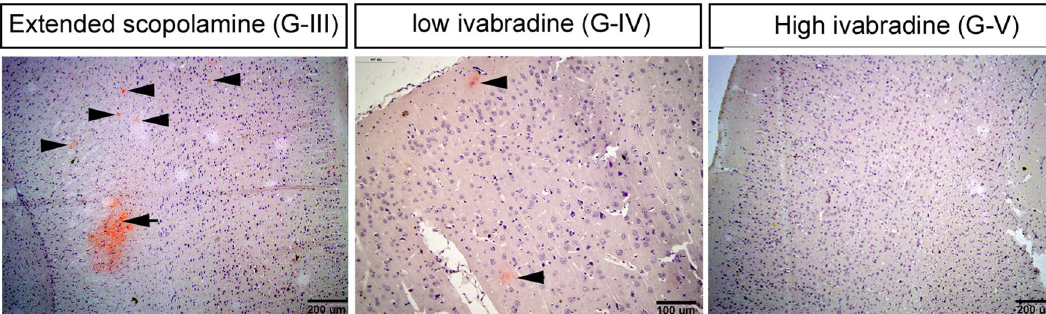
Figure 7. Showing the amyloid plaques stained with congo red. On the left panel, there are many plaques of both large and small sizes in the extended scopolamine group. In the middle, after low ivabradine the plaques become less frequent and of small sizes only. The plaques disappear from the cortex and hippocampus in case of ES group.